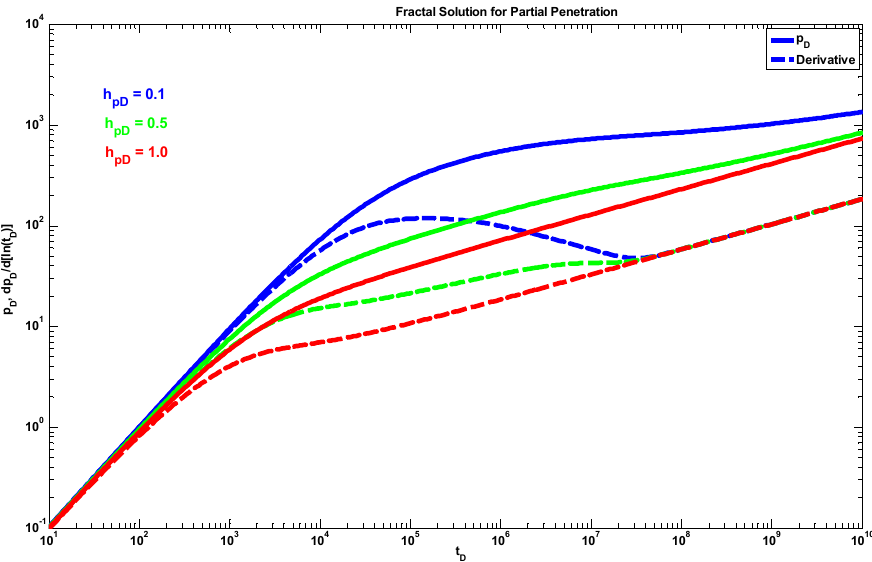
Figure 10. Fractal case: z wD = 0, h D = 10,000, S = 0, C D = 100, ε = 1, d fr = 1.5, θ r = 0, d fz = 1.0,